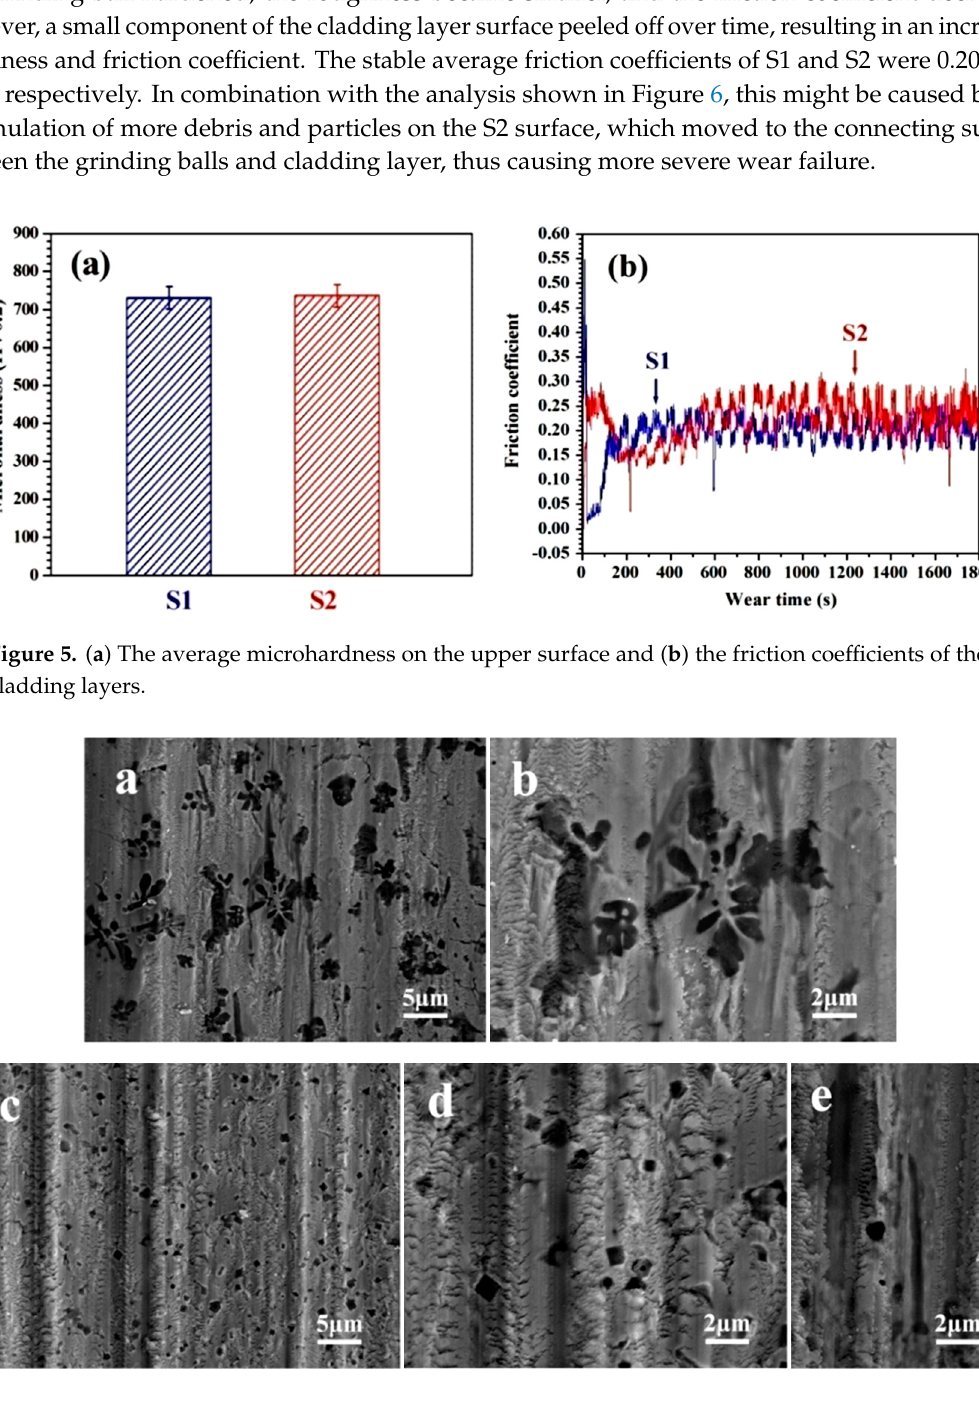
Figure 6. Secondary electron micrograph of wear morphologies ( a ) ( b ) S1 and ( c – e ) S2 cladding layer.